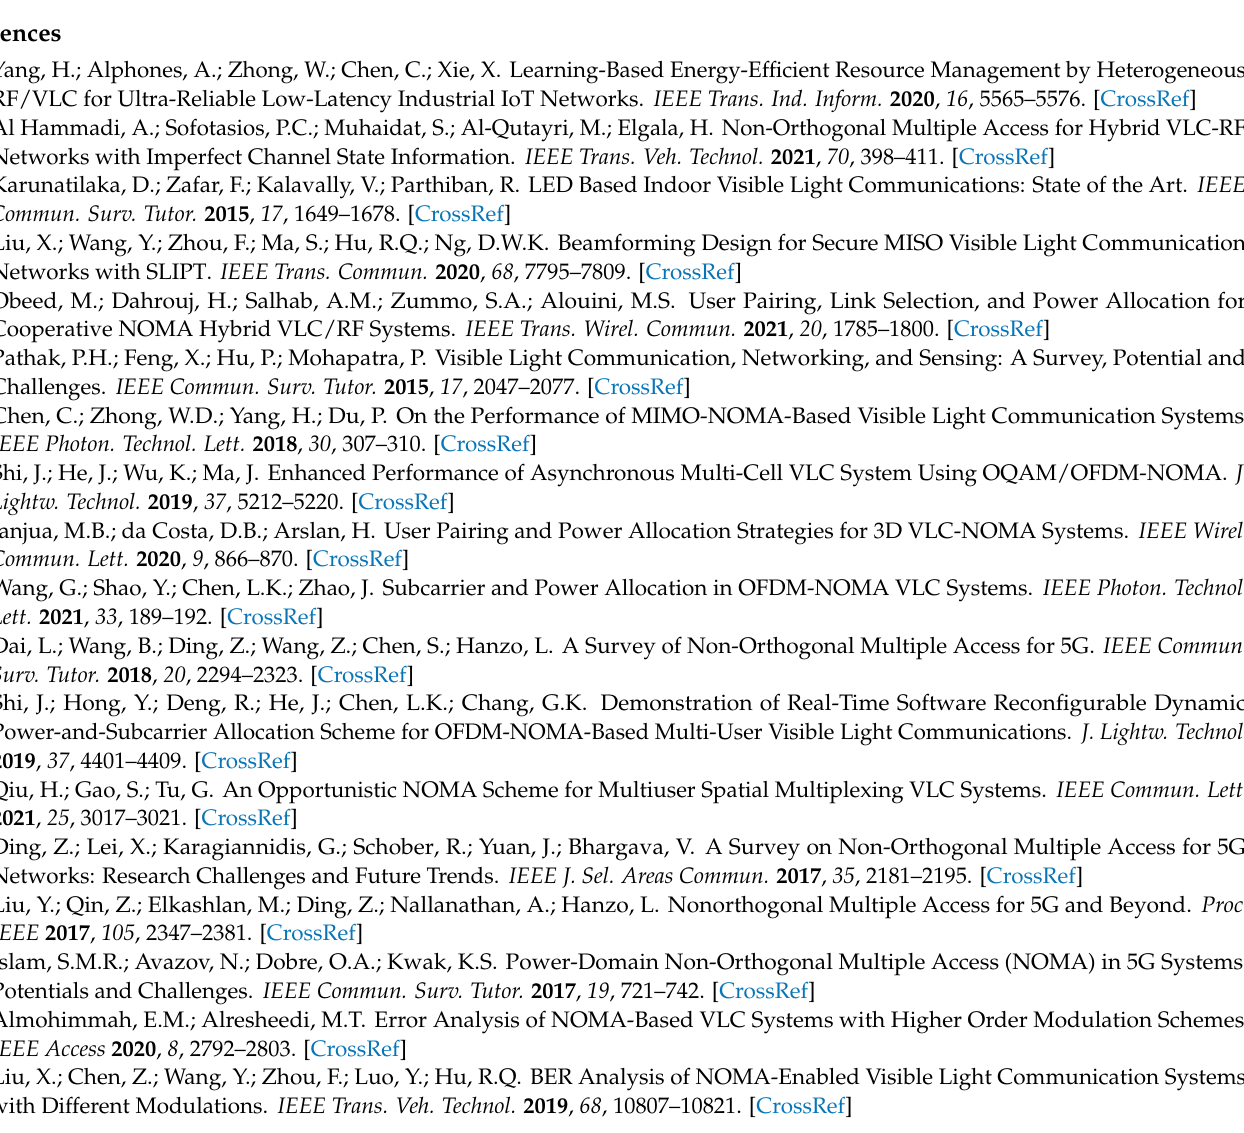
Figure A2. The constellations of the adjusted SC point ( x (cid:48) in four-user NOMA VLC system. ( a ) The constellation of Case I and ( b ) the constellation of Case